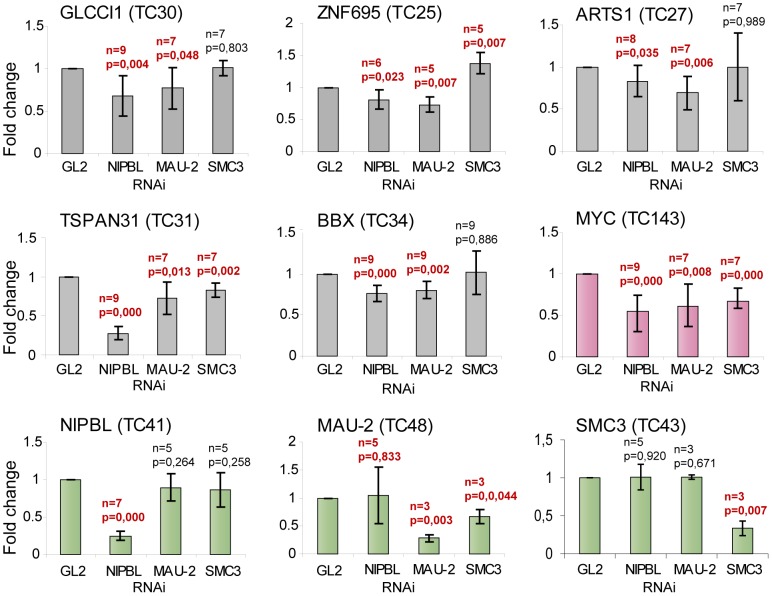
NIPBL is important to maintain gene activity.Transcript levels of genes with NIPBL-bound promoters and no cohesin sites close to the gene (GLCCI1, BBX, TSPAN31, ARTS-1 and ZNF695) and the cohesin-regulated MYC gene were analyzed by RT-PCR/qPCR after RNAi depletion of NIPBL, MAU2 or SMC3 in HB2 cells. The cells were synchronized in G2 phase and the transcript levels are normalized against the housekeeping gene NAD. Transcripts of NIPBL, MAU2 and SMC3 were also analyzed to exclude that NIPBL affects transcription of MAU2 and SMC3 and vice versa. All three genes serve also as negative control genes without NIPBL binding site at the promoter, although MAU2 and SMC3 have intronic cohesin binding sites. P-values were determined using Students test using between 3 and 9 independent biological replicates. The p-value and number of replicates is indicated for each graph. Values that are significantly different (P-value<0.05) from control RNAi are highlighted in red. (error bars ± s.d.).